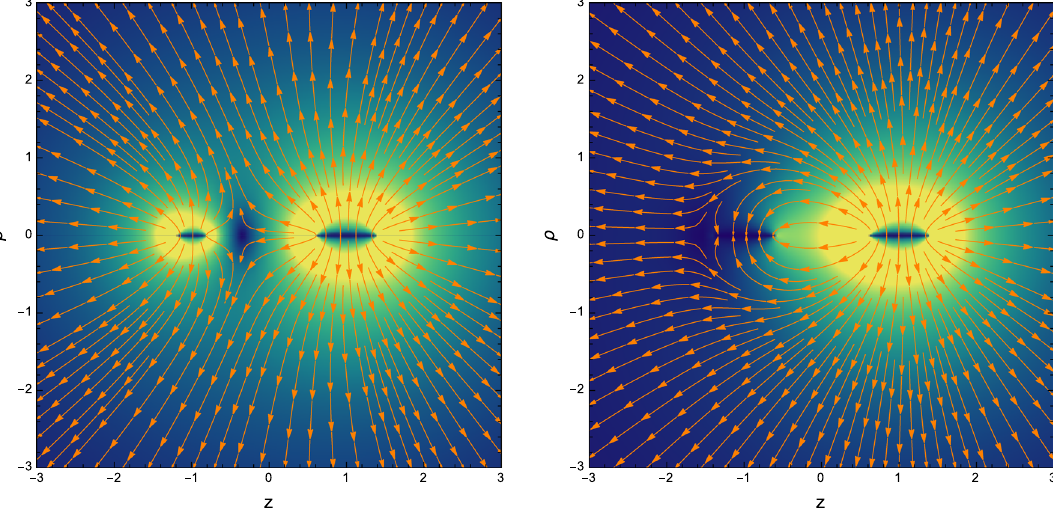
Fig. 3 Electromagnetic structure of a two magnetic monople fields in a binary black hole system of unequal mass and charge ( left ) and one monopole field on (equal mass) binary black hole system ( right